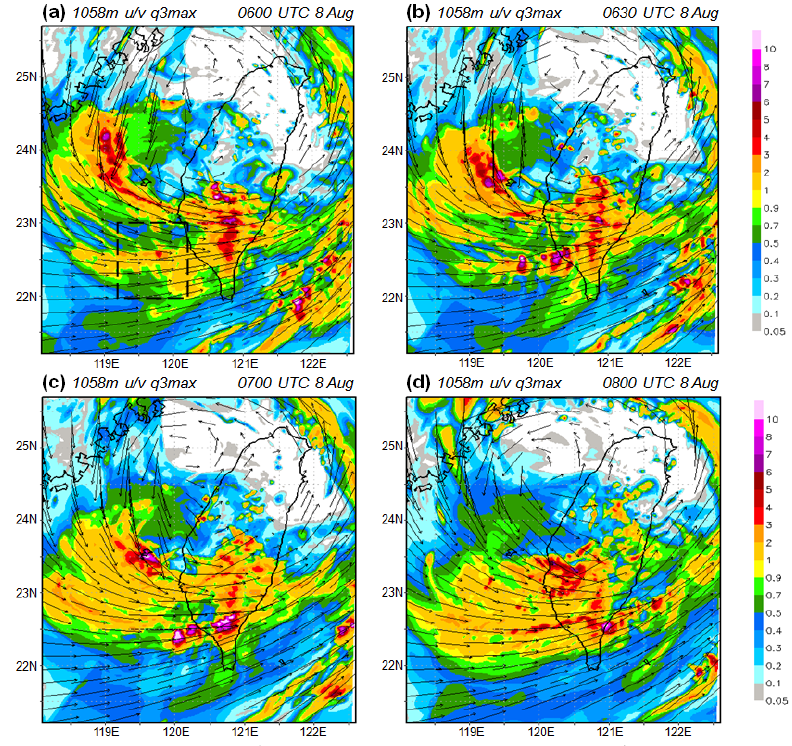
Figure 7. Model-simulated column maximum mixing ratio of total precipitating hydrometeors (gkg − 1 , rain + snow + graupel, colors, scales on the right) and horizontal winds (ms − 1 , reference vector at bottom) at 1058m at (a) 06:00UTC, (b) 06:30UTC, (c) 07:00UTC and (d) 08:00UTC, 8 August 2009 in the 1km run. The dashed box in (a) depicts the area of pressure perturbation calculation (22–23 ◦ N, 119.2–120.2 ◦